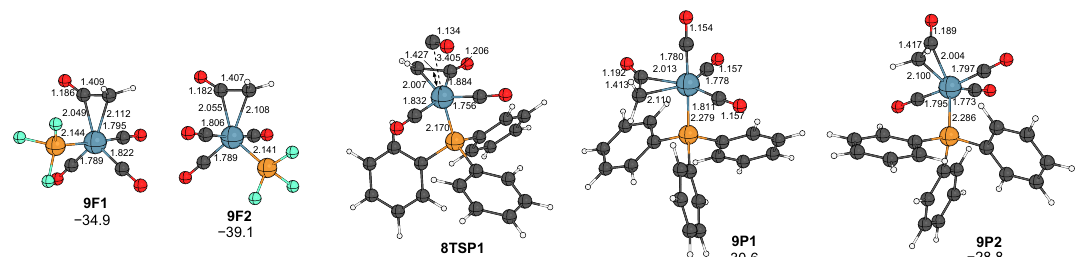
Figure 6. Computed minimum structures of the coordinatively saturated ketene complexes and transition states associated with the CO uptake in the presence of triphenylphosphine. Bond distances are in Å, Gibbs free energy values are given in kcal/mol, and they are relative to 1F and 1P .